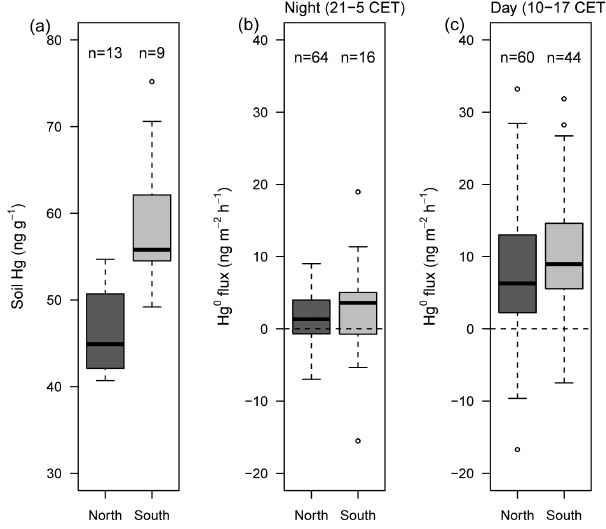
Figure 8. Boxplots displaying (a) the total topsoil Hg concentration (0–10cm) in the northern and the southern parcels as well as the Hg 0 flux over the respective parcels (b) during the night (21:00– 05:00) and (c) during the day